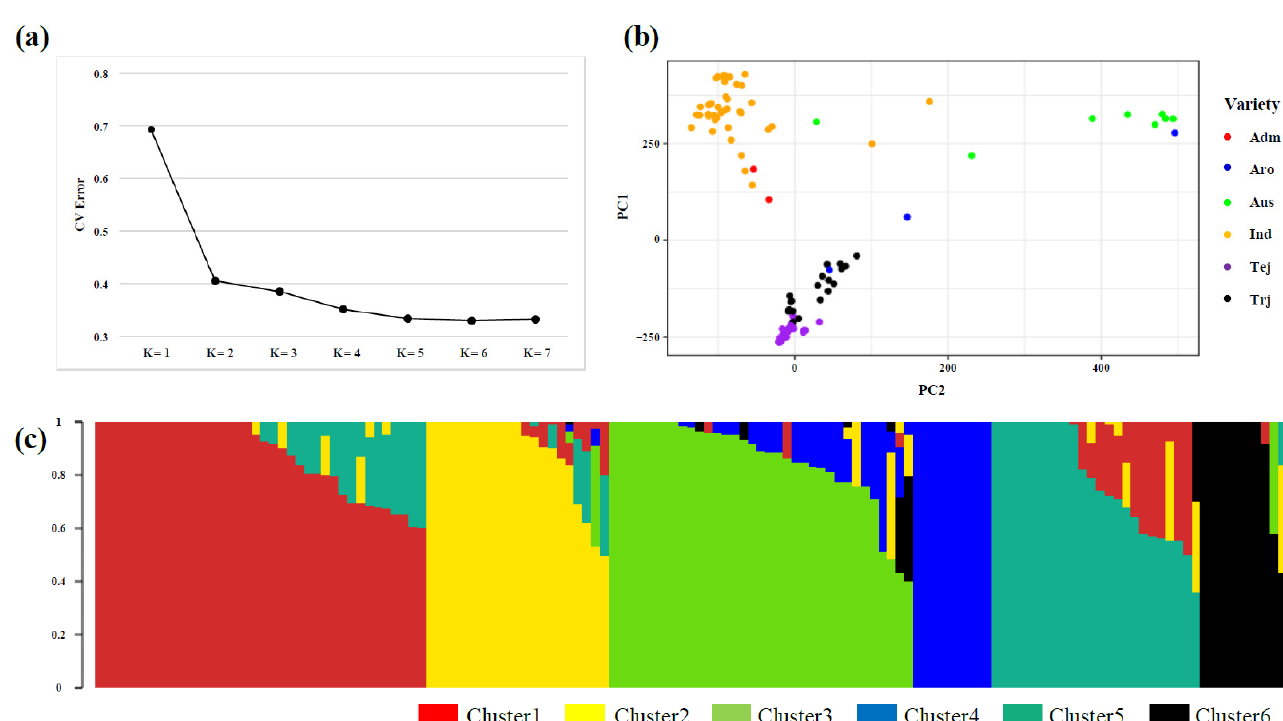
Figure 2. Population structure analysis based on 137 rice accessions. ( a ) Cross-validation (CV) error of diverse groups (K). The dotted transverse line represents the lowest level; ( b ) Principal Component Analysis (PCA) (PC1 and PC2). red, blue, green, orange, purple, and black represent the Adm, Aro, Aus, Ind, Tej, and Trj rice subspecies, respectively; ( c ) Plot for population structure analysis at K = 6.